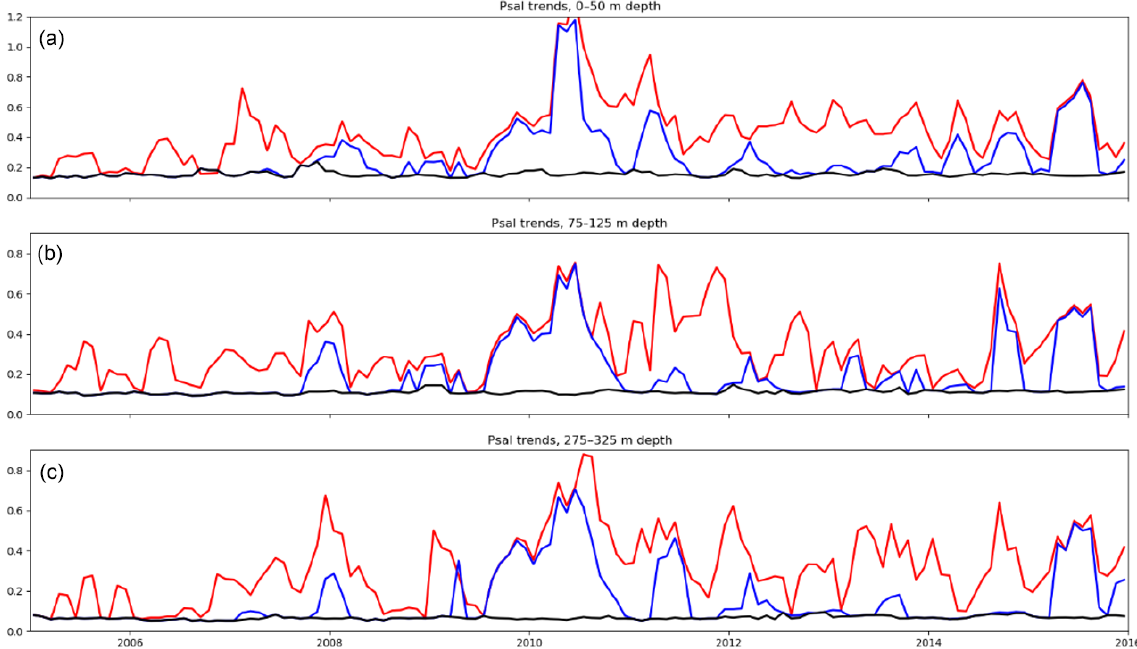
Figure 7. Mean salinity standard deviation in the 0–50m layer (a) , 75–125m depth layer (b) , and 275–325m depth layer (c) . The raw dataset (red), NRT dataset (blue), CORA dataset (black) are